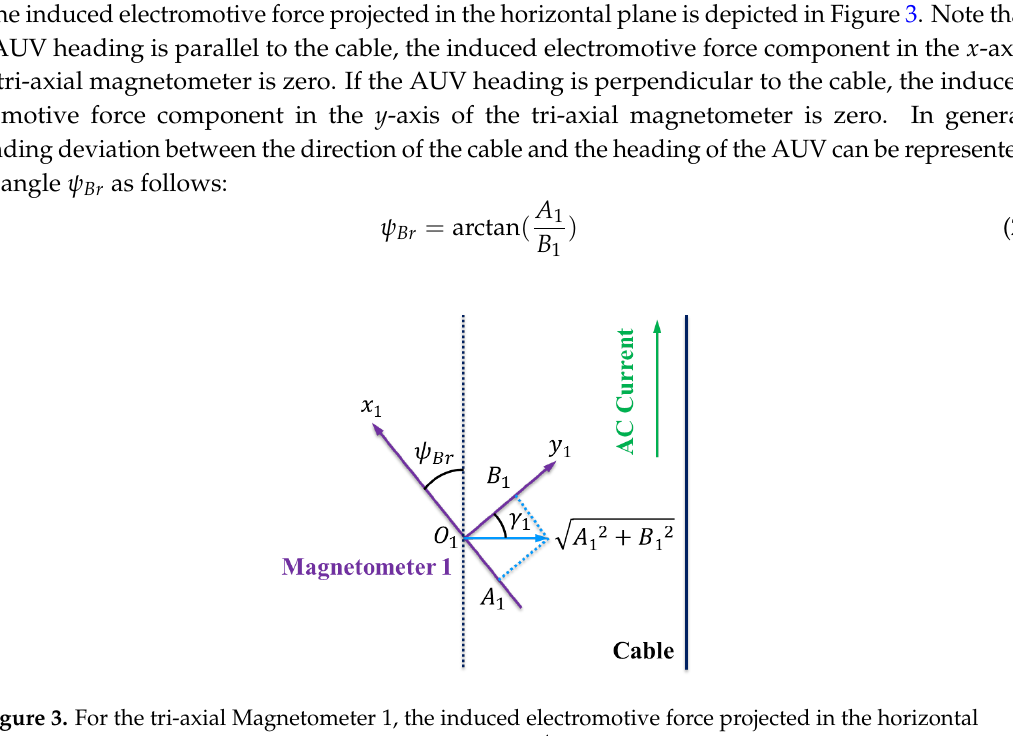
and γ 1 = ψ Br . B 1